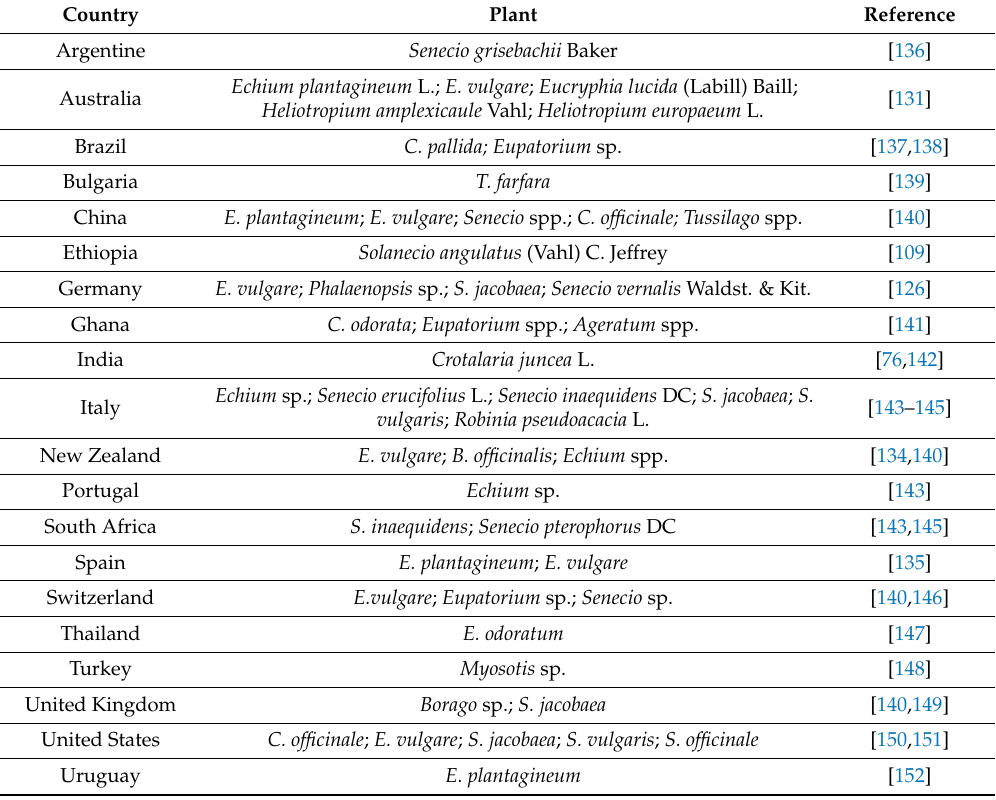
Table 2. Plants containing PA used in the production of honey in several